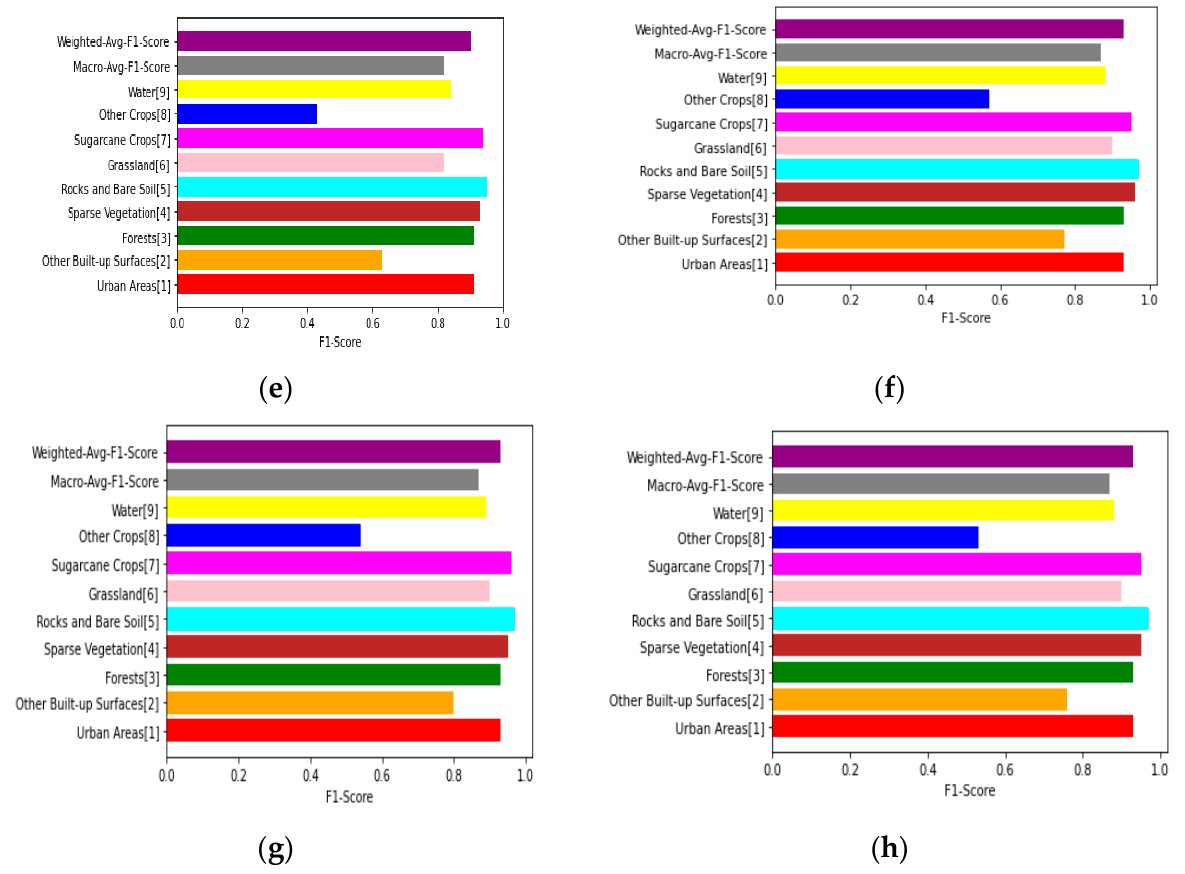
Figure 7. F1 scores of land cover classification for the time series dataset using the deep learning model: ( a ) bidirectional GRU; ( b ) temporal CNN; ( c ) GRU + temporal CNN; ( d ) attention on tem- poral CNN; ( e ) attention on temporal CNN + GRU; ( f ) univariate + multivariate + coordinates; ( g ) univariate + multivariate; ( h ) univariate + multivariate (LSTM) + coordinates.